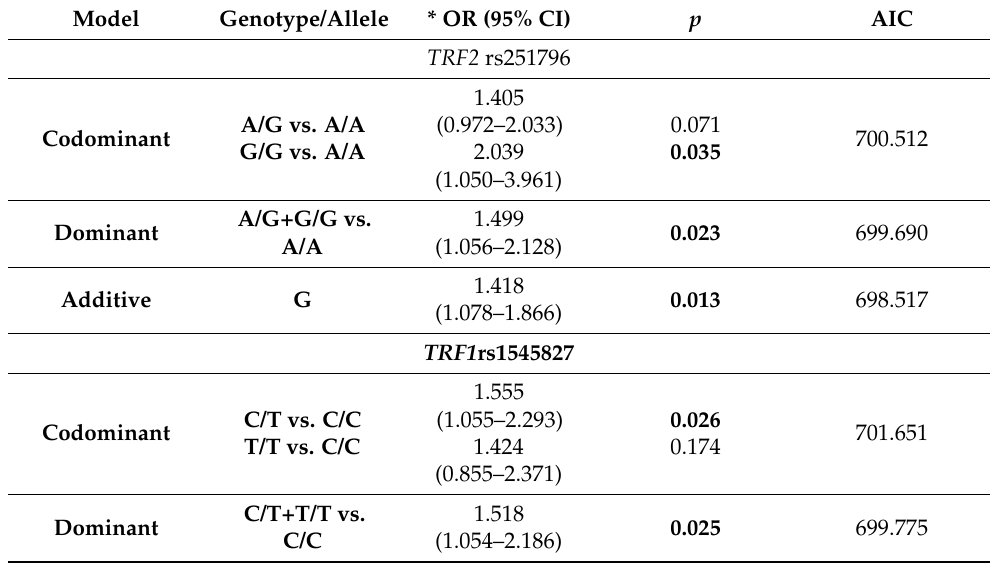
Table 6. Binomial logistic regression analysis of TRF2 rs251796 and TRF1 rs1545827 in telomere